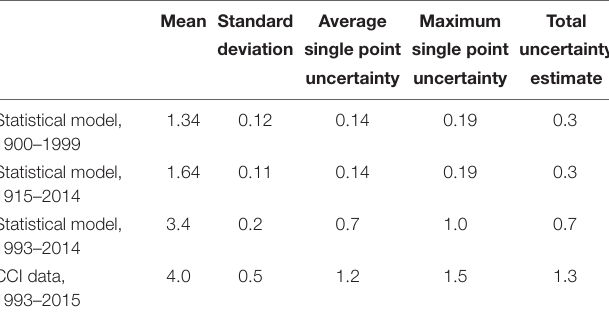
into account, yielding a total uncertainty of approximately √ 0 . 2 2 + 0 . 2 2 = 0.3